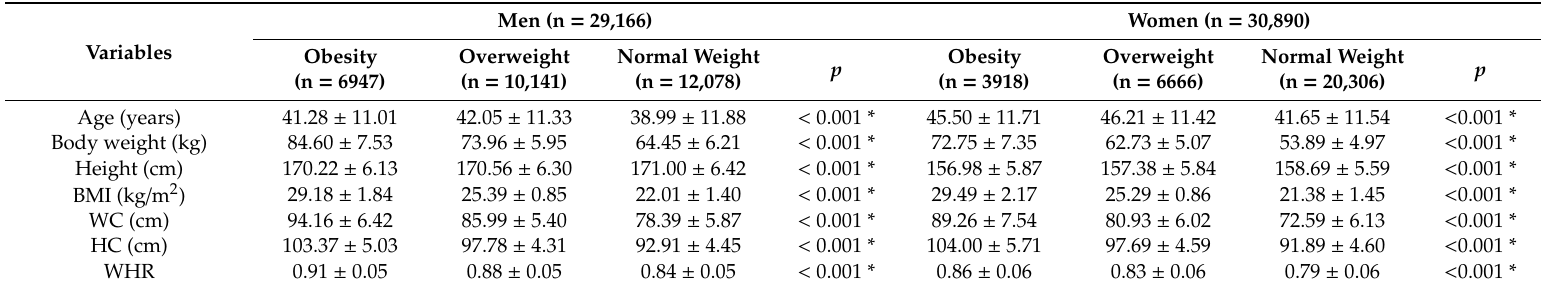
Table 1. Anthropometric measurements of the study